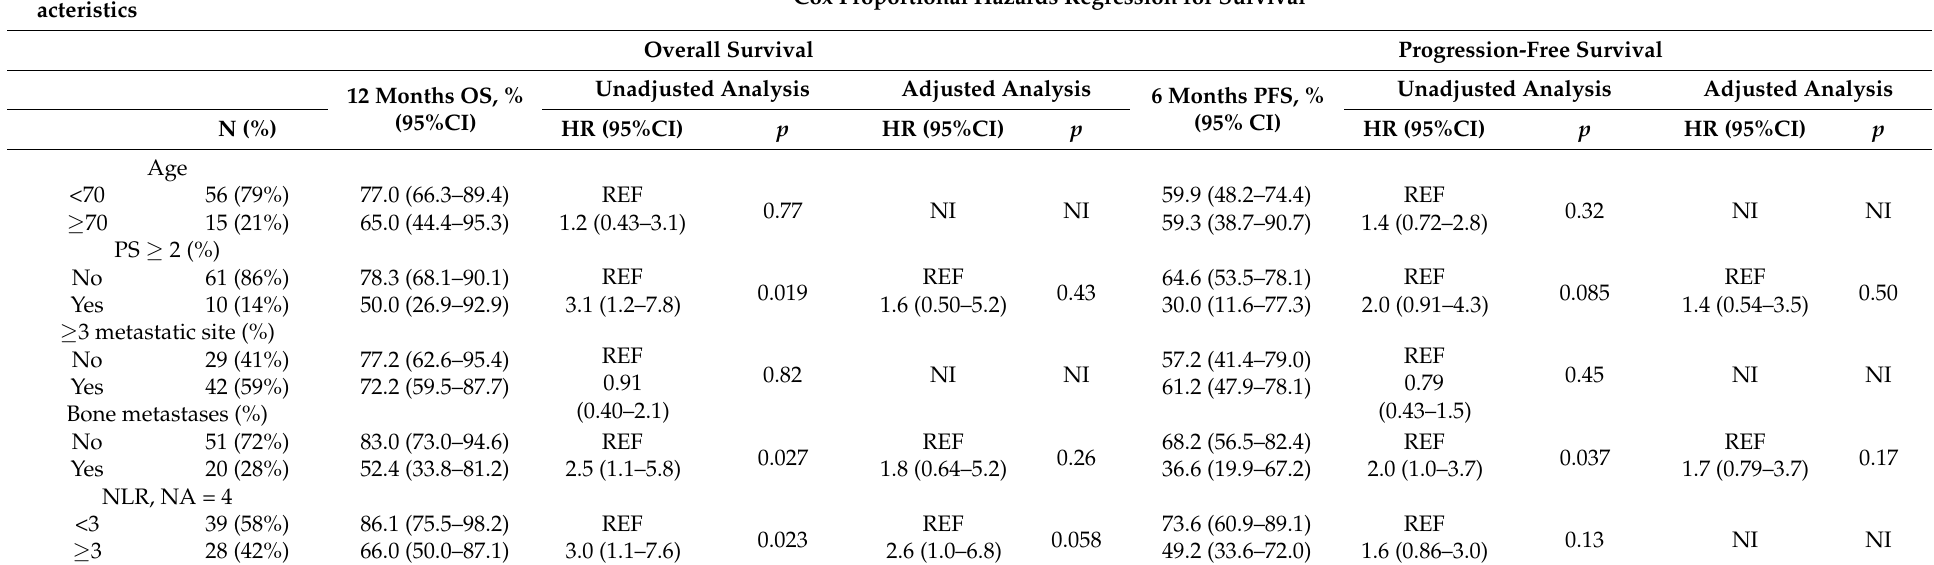
Table 2. Prognostic factors of overall survival and progression-free survival among the whole patients treated with ipilimumab plus nivolumab according to the Cox